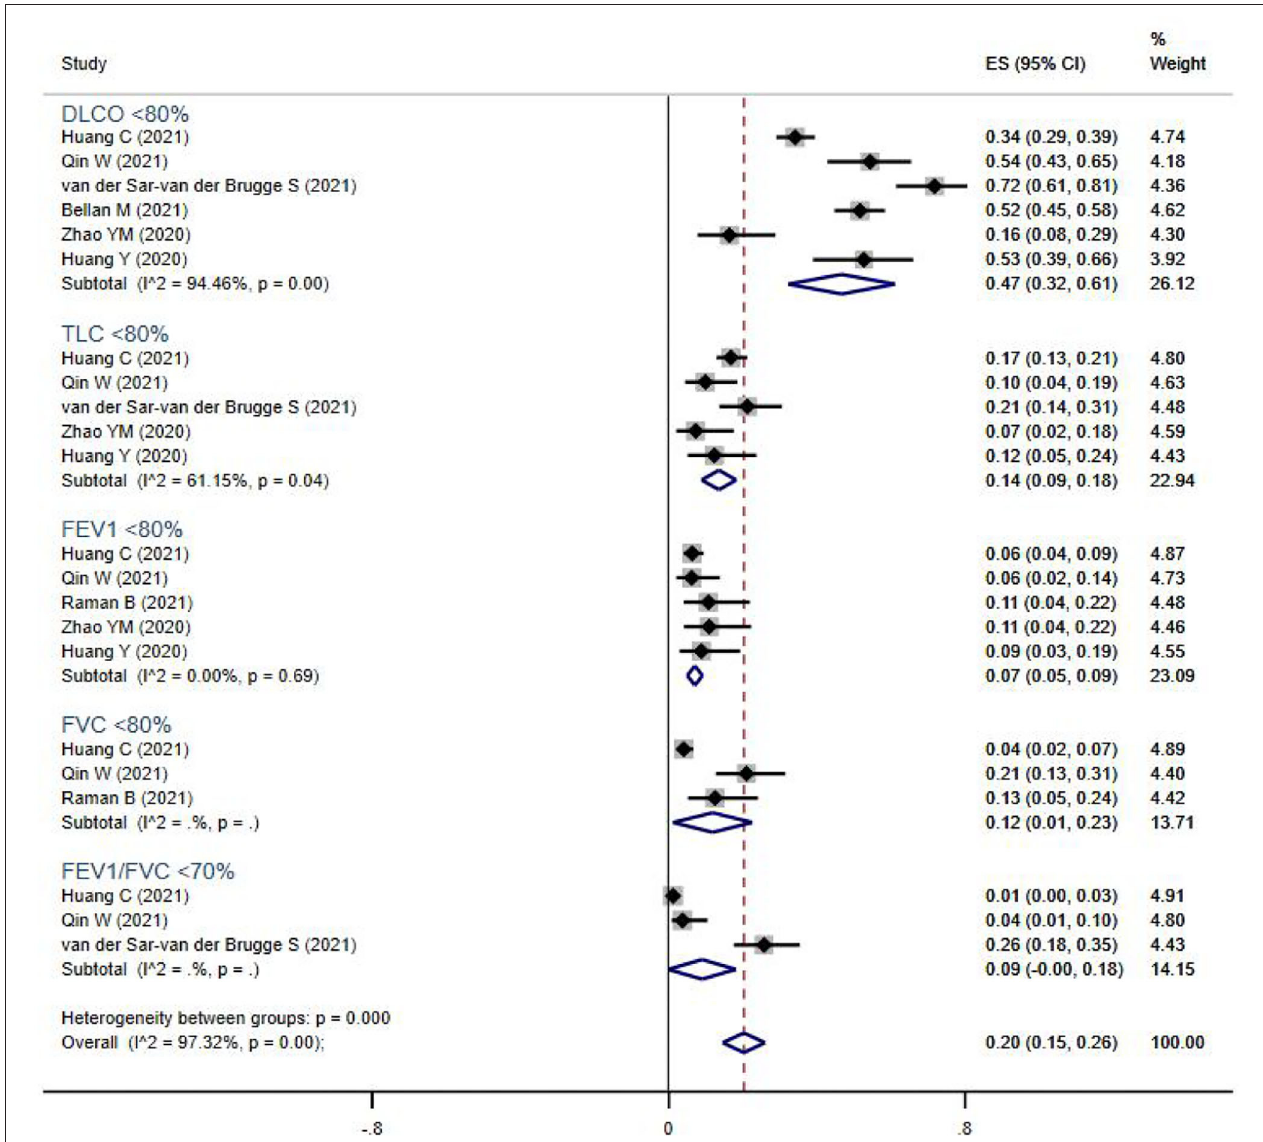
FIGURE 2 | The forest plot of the prevalence of abnormal lung function parameters, with a range from 1 to 72%. The brown dashed line at 0.2 on the x-axis represents the overall prevalence (20%, 95% CI 15–26%) of these parameters. The blue rhombuses represent prevalence and 95% CI of each outcome. DLCO, diffusion capacity for carbon monoxide; TLC, total lung capacity; FEV1, forced expiratory volume in the first second; FVC, forced vital